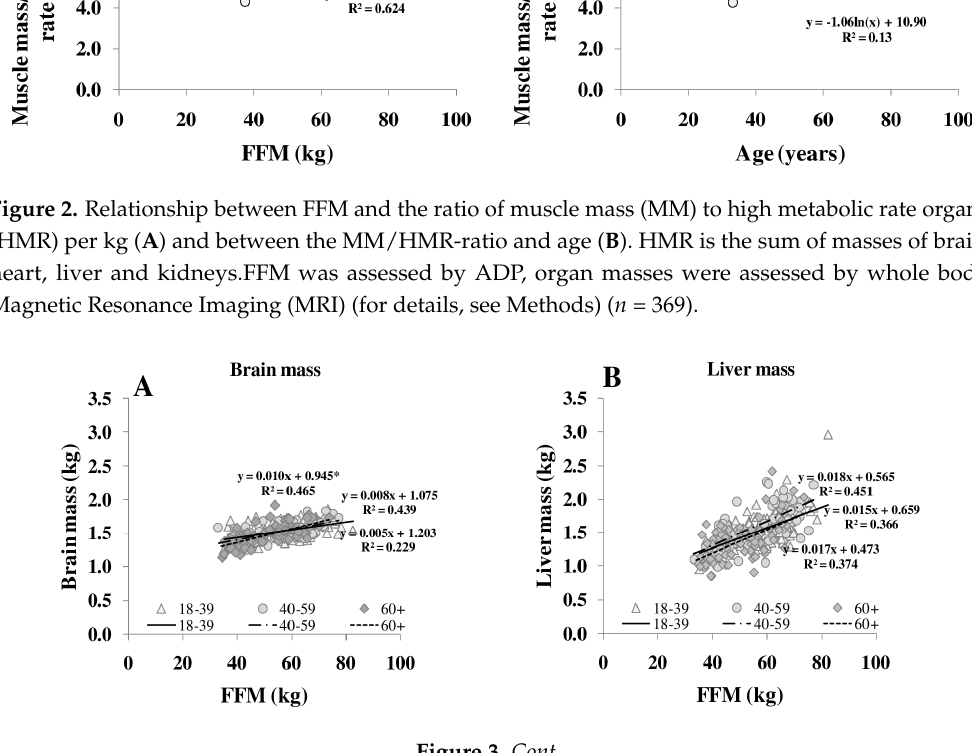
Figure 2. Relationship between FFM and the ratio of muscle mass (MM) to high metabolic rate organs (HMR) per kg ( A ) and between the MM/HMR ‐ ratio and age ( B ). HMR is the sum of masses of brain, heart, liver and kidneys.FFM was assessed by ADP, organ masses were assessed by whole body Magnetic Resonance Imaging (MRI) (for details, see Methods) ( n = 369).